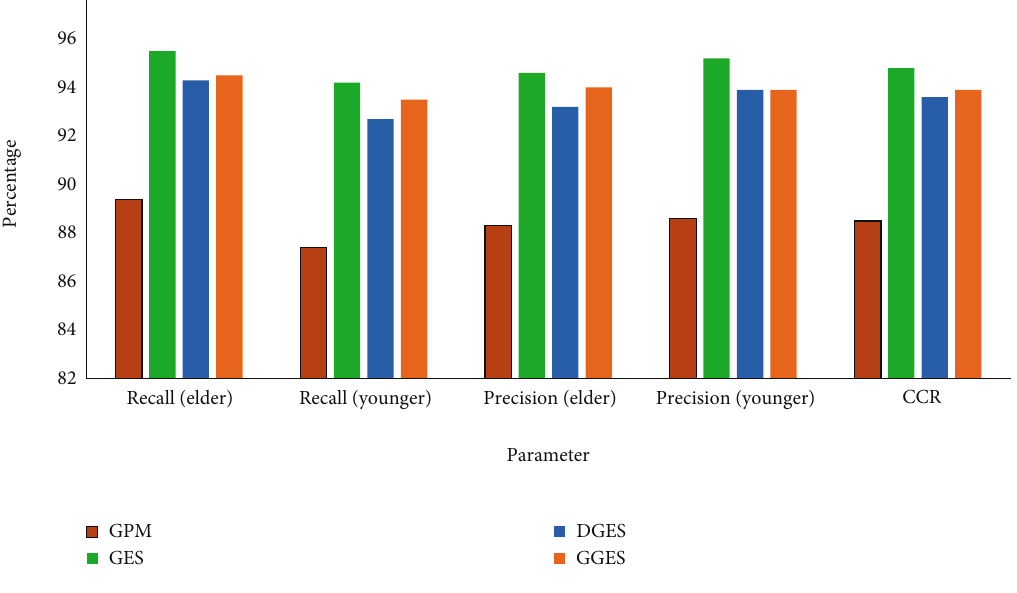
Figure 10: Gender recognition with GA and SVM.